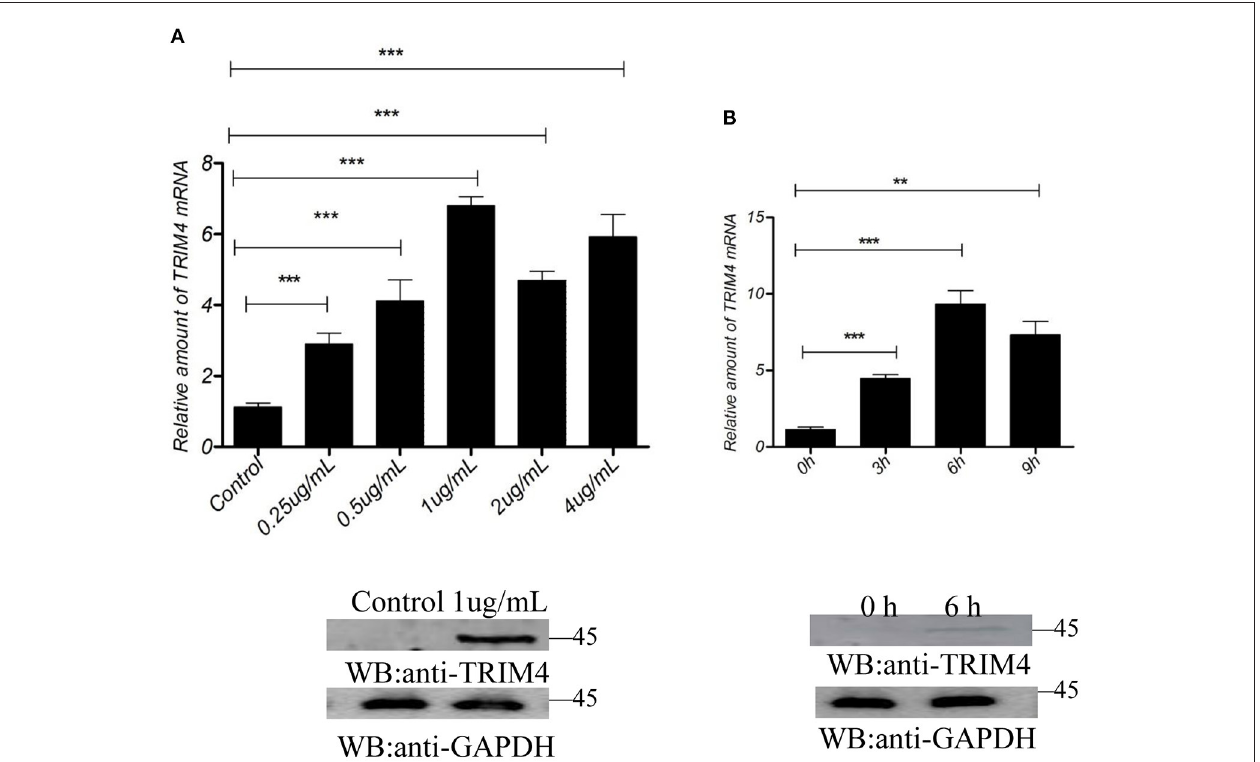
FIGURE 4 | Poly(dA: dT) response to TRIM4 expression. (A) TMARC145 cells were transfected with poly(dA: dT) at different doses (0, 0.25, 0.5, 1, 2, and 4 µ g/mL). After 9h, the changes in TRIM4 were determined by qPCR and western blotting. (B) Evaluation of different time points with the same poly(dA: dT) concentration on TRIM4 expression. Poly(dA: dT) (1.0 µ g/mL) was transfected into MARC145 cells. The expression of TRIM4 was assessed by qPCR and western blotting at the designated time points (0, 3, 6, and 9h). ** P < 0.01; *** P <